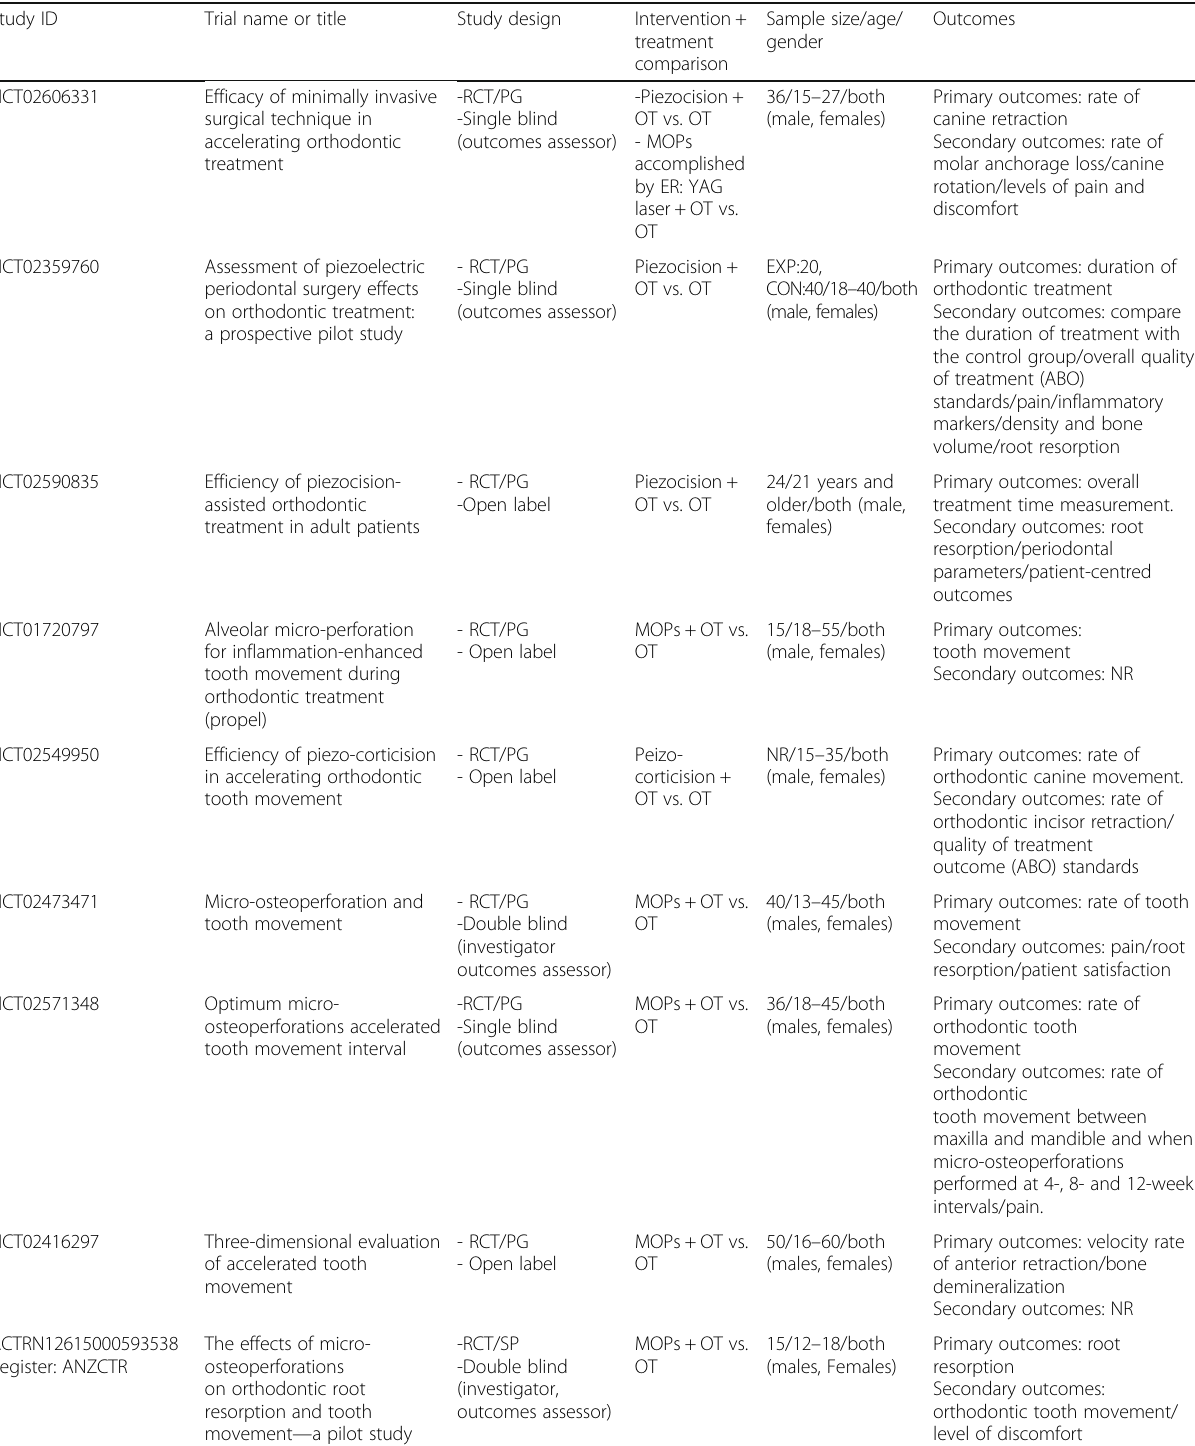
Table 2 Protocols of the ongoing studies registered at the clinical.trials.gov and the ANZCTR Study